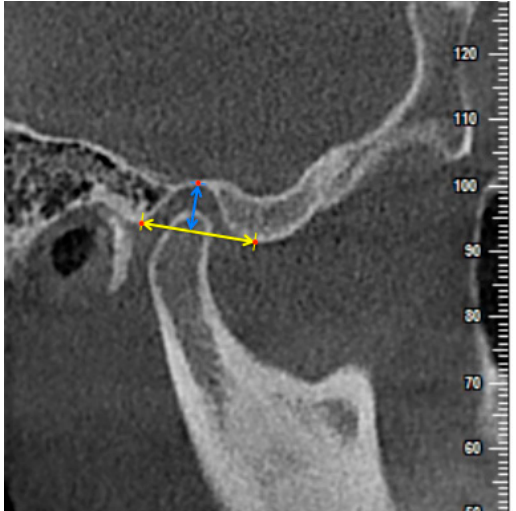
Figure 5. The measurement of the width of the glenoid fossa (GFW) and depth of the glenoid fossa (GFD) on the central sagittal slice. The distance between the crest point of the articular eminence and the posterior part of the glenoid process was measured as the GFW (yellow arrow) and the perpendicular distance between the highest point of the glenoid fossa and the GFW line was measured as the GFD (blue arrow).